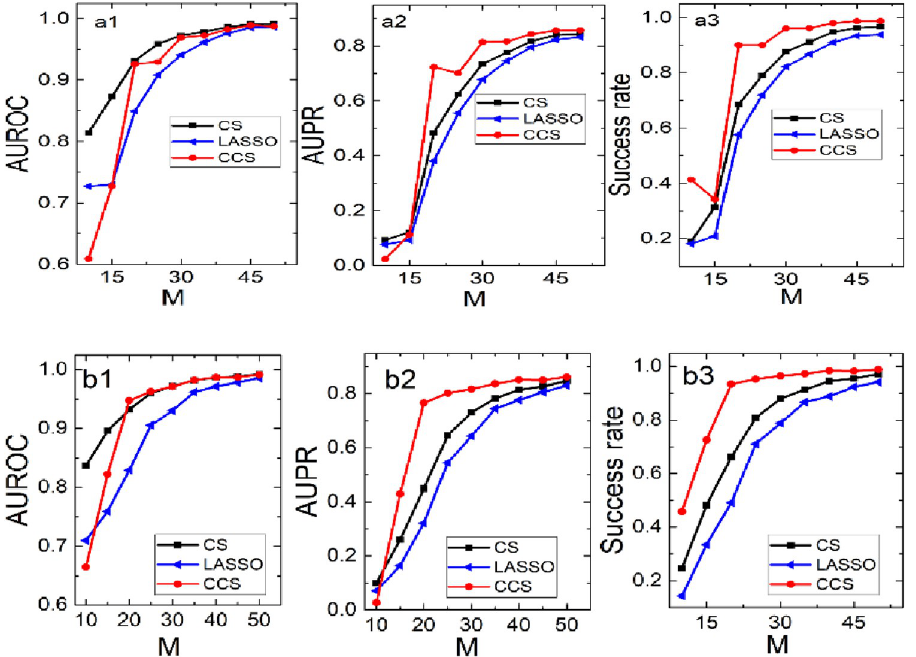
Fig 5. The performance of three methods as sample size increases from10 to 40. (a1-a3): Group {C, D, WSLS} (b1-b3): Group {C, D, WSLS, ZD}.